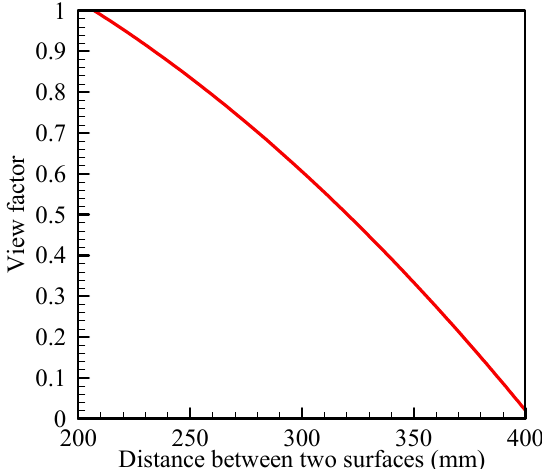
Figure 5. View factor curve used in the FE analysis.